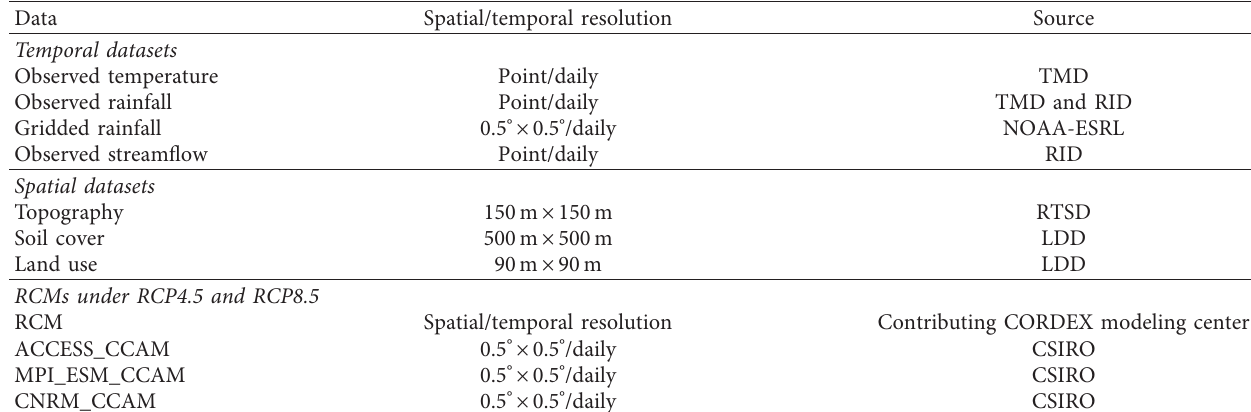
Figure 2: (a) Topography, (b) soil cover, and (c) land use in the upper Nan River basin. Table 1: Temporal and spatial data